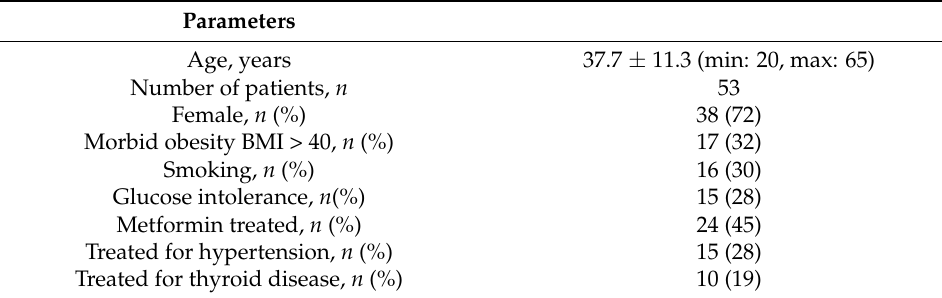
Table 2. Baseline characteristics of study subjects.